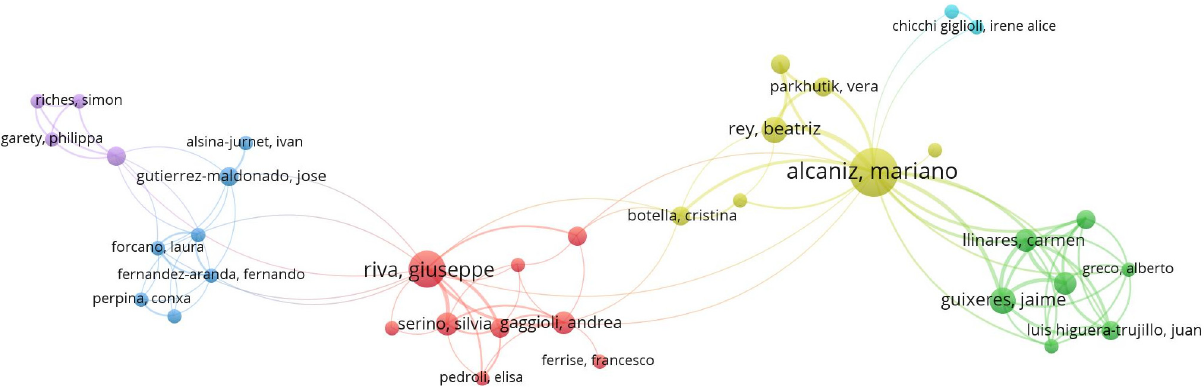
Figure 7. Map of author collaboration networks.